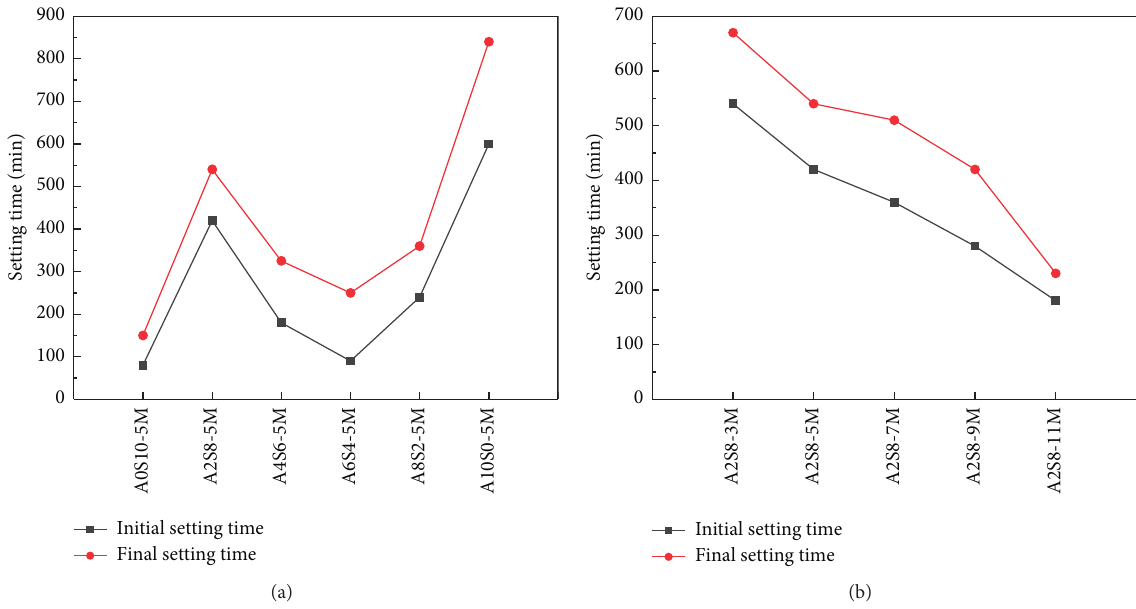
Figure 3: AAS setting time with different NaAlO